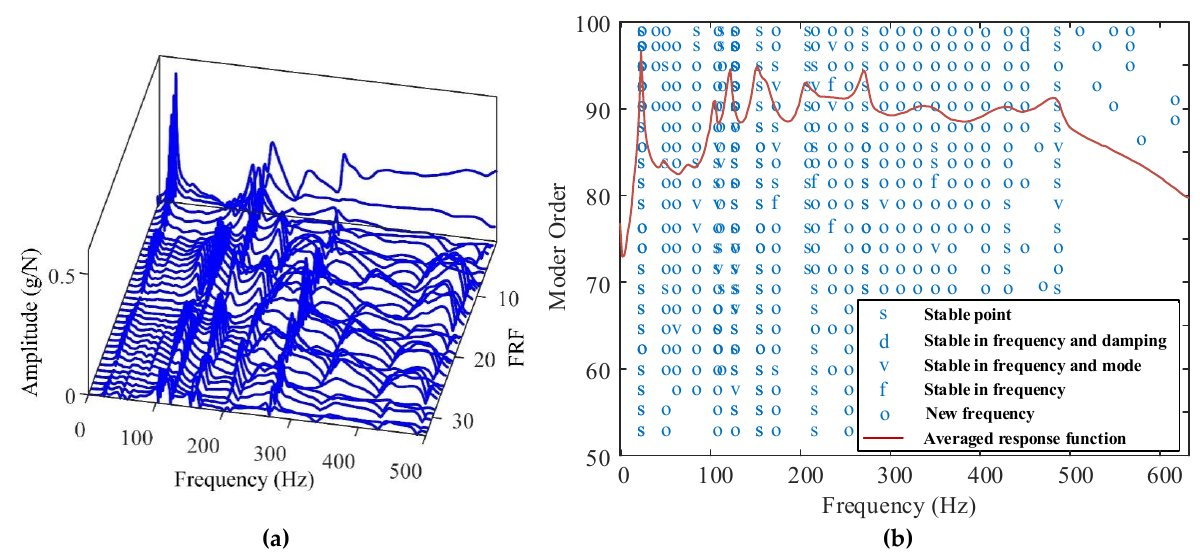
Figure 5. The eigensystem realization algorithm for modal parameter identification: ( a ) FRF of 33 excitation points; ( b ) Stabilization diagrams. Table 1. Natural frequency of the non-running propulsion shafting under the linear alignment state. Order-Number